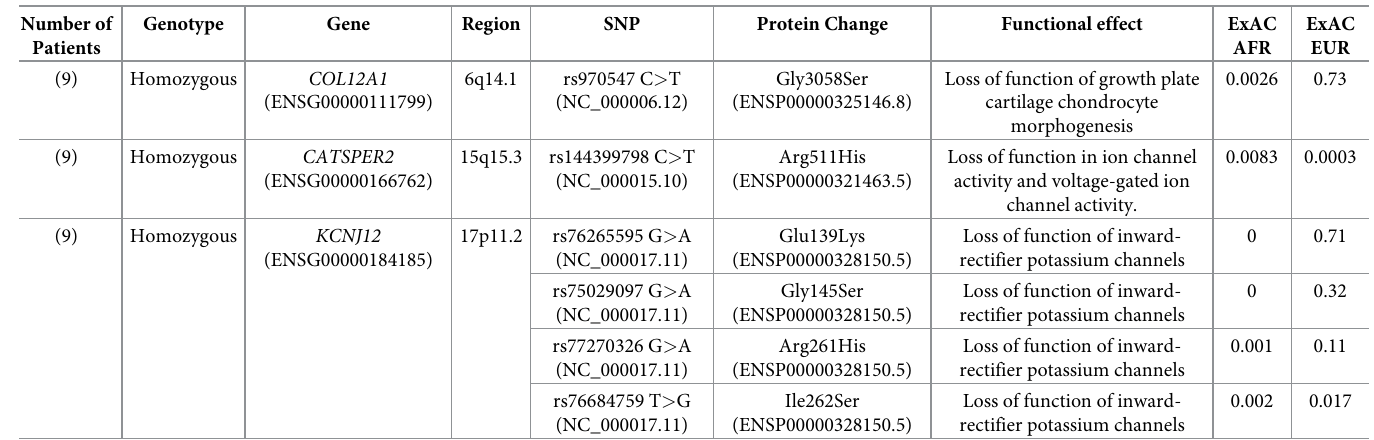
Table 1. Predicted functional effect of mutations common to Family A and Family